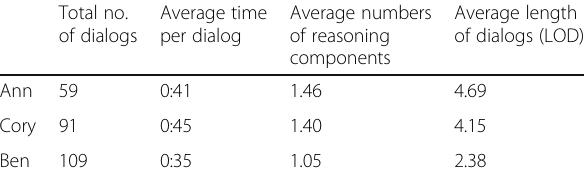
Table 5 Comparison of each teacher ’ s discourse patterns Total no. Average time Average numbers of dialogs per dialog of